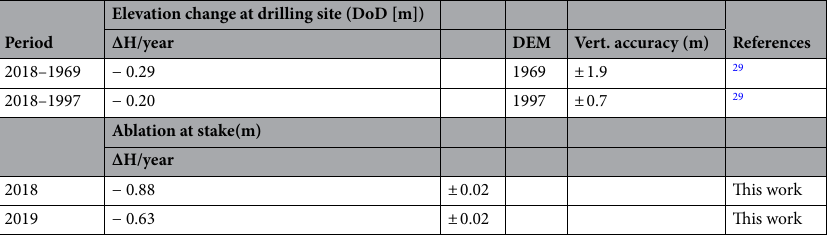
Table 1. Elevation change as ice loss indicator at Weißseespitze summit, given in metres per year and derived from digital elevation models (DEM, previous studies) and direct measurements by ablation stakes (this work). DoD difference of